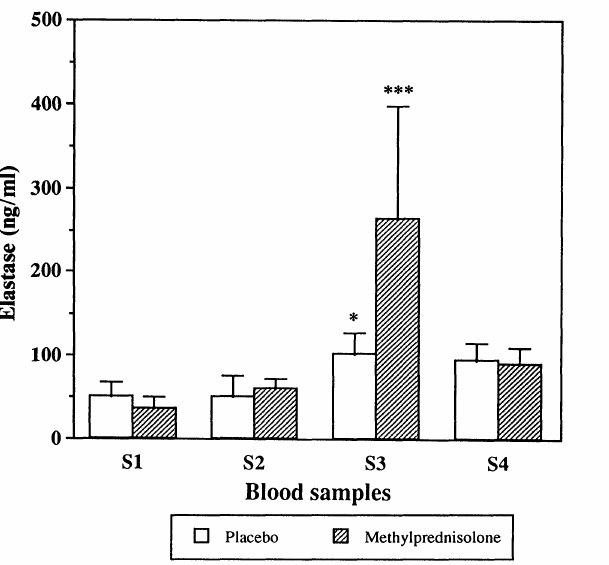
FIG. 1. Blood polymorphonuclear neutrophil counts as a function of time in the two experimental conditions (Sl: 10 min after catheter insertion; S2: 3h after ingestion of a capsule containing either a placebo or 32 mg methylprednisolone; S3: immediately after the run; S4: after 20 min recovery). Vertical bars are SD (n 0.4). *Significantly different from pre-exercise level (S2): p < 0.05; **Significantly different from baseline level: p <